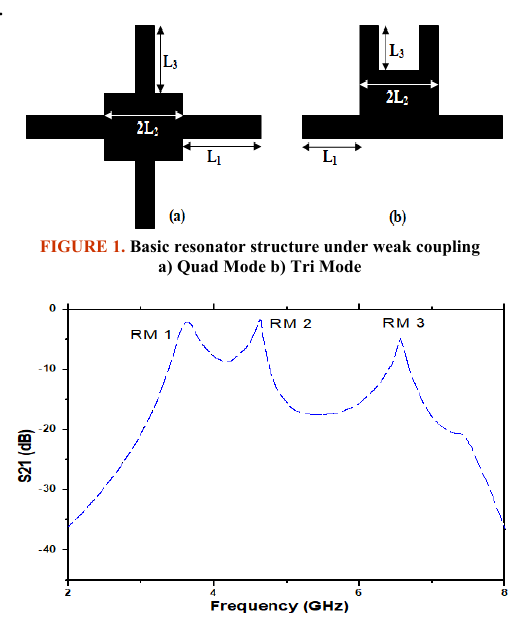
FIGURE 3. f 1 , f 2 , f 3 variation with L1